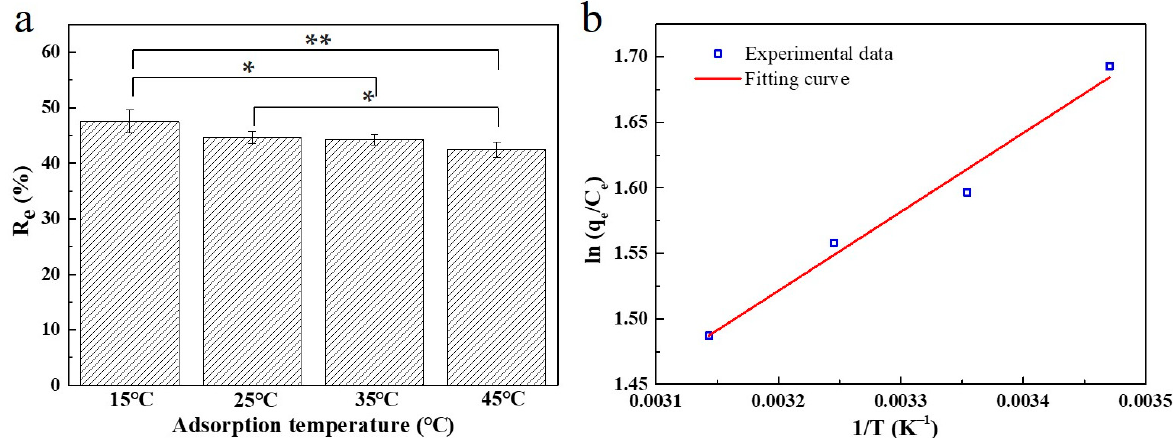
Figure 9. ( a ) The effect of adsorption temperature for the adsorption of MB onto SC1050 and ( b ) the plot for estimation of thermodynamic parameters. (n = 3, * p < 0.05, ** p < 0.01). Table 4. Thermodynamic parameters for the adsorption of MB onto SC1050.